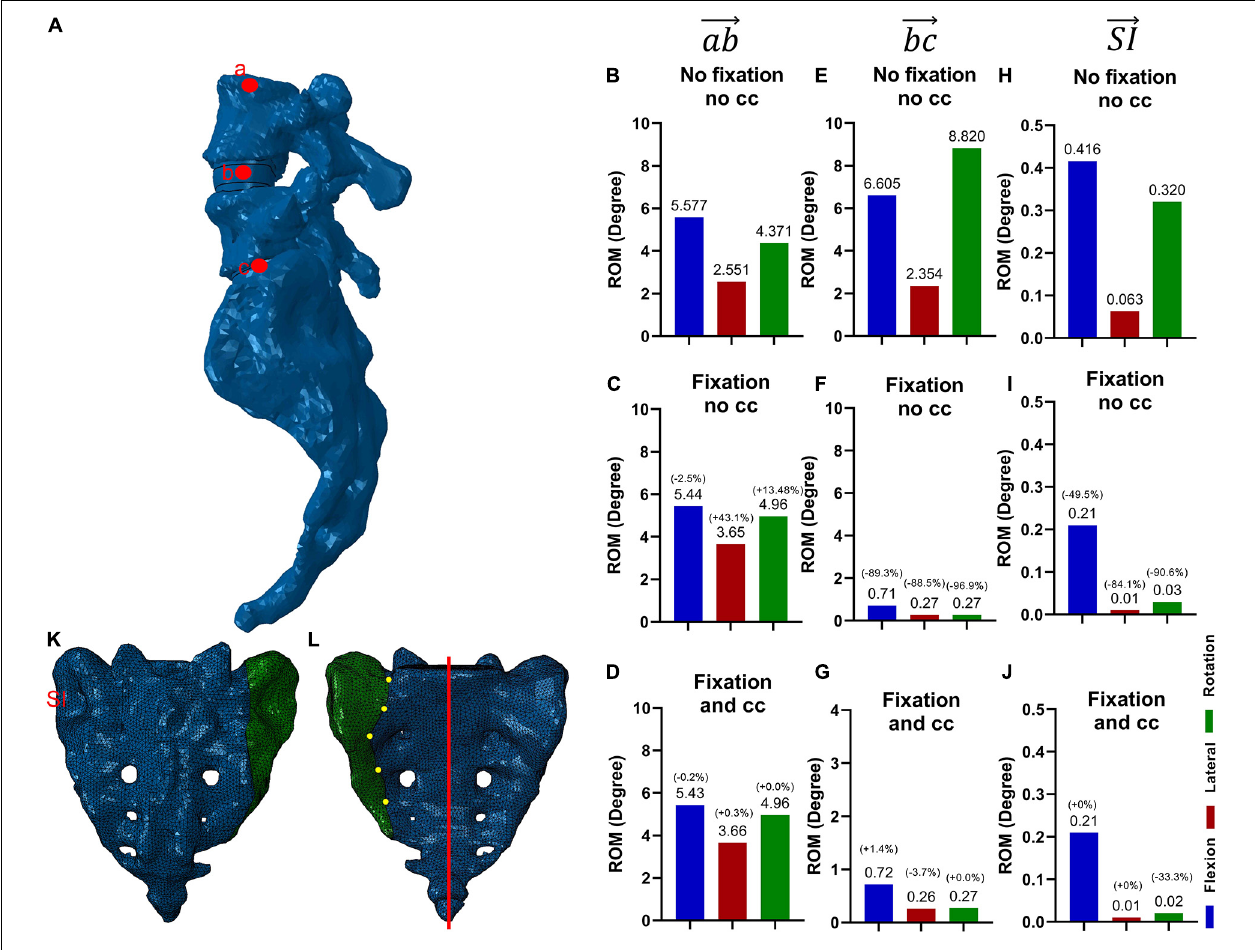
FIGURE 2 | Lumbopelvic axis and three measuring points for range of motion (ROM) (A) and corresponding motion (for all three conditions and vector −→ vector −→ E–G , −→ H–J ) and addition of a central vertical sacral fracture (Denis zone I, K, L). The range of motion was assessed along the vector −→ ( bc ) ( SI ) motion from L4 to L5 without fixation (B) , with fixation without (C) and with (D) the cross connector, whereas the motion from L5 to the sacrum is labeled by the vector −→ , again measured without fixation (E) , with fixation without (F) and with (G) the cross connector. The SI ROM is measured by the vector −→ ( bc ) in H–J . A central transalar sacrum fracture, Denis classification zone I (identified by yellow dots), was created to simulate the most common central sacrum fracture type (K,L) (Denis et al., 1988). The red line in L depicts the cut surface for Figures 6D–F